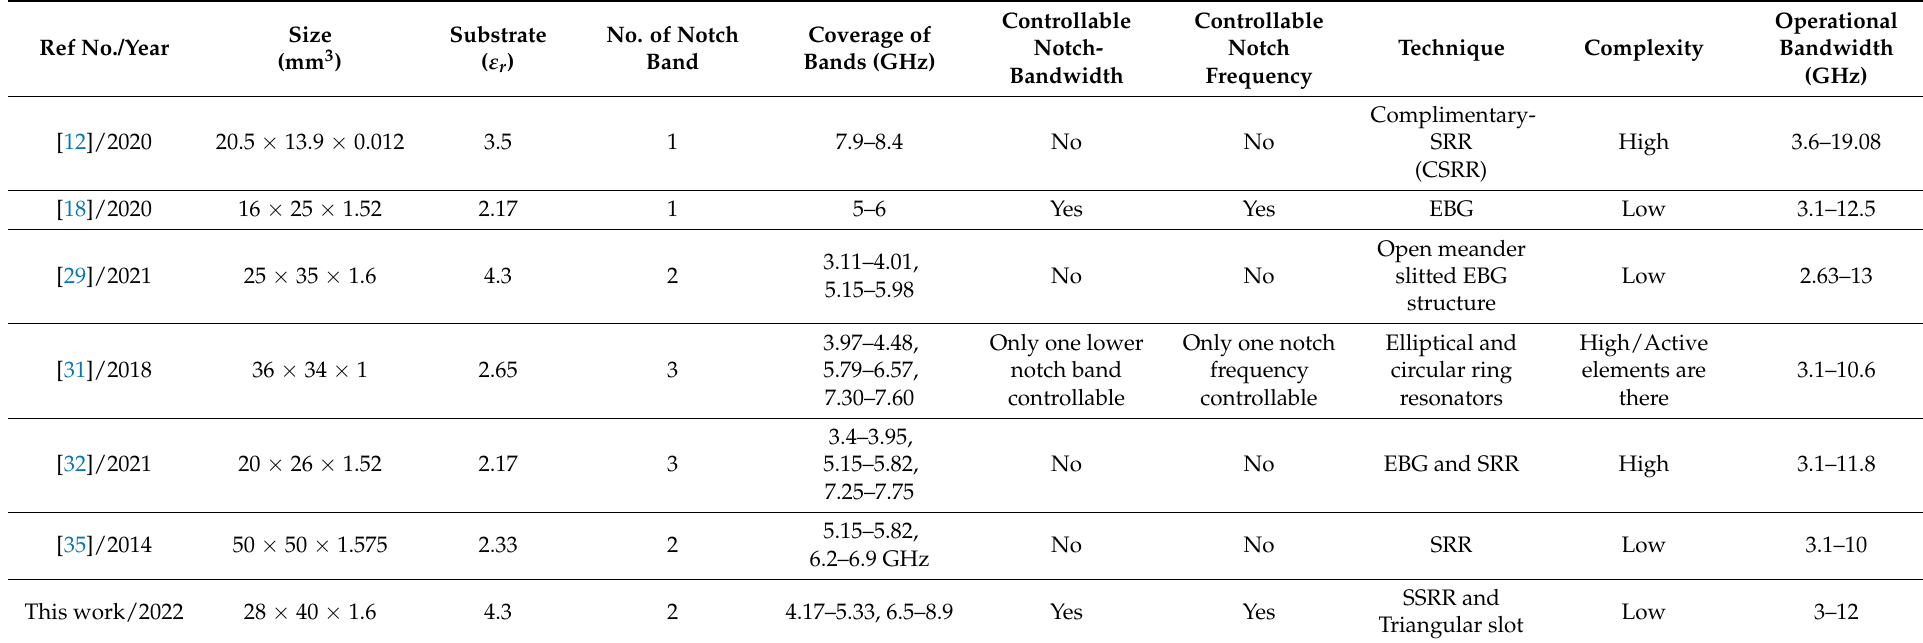
Table 4. Comparative study between the proposed antenna and existing MTM-based